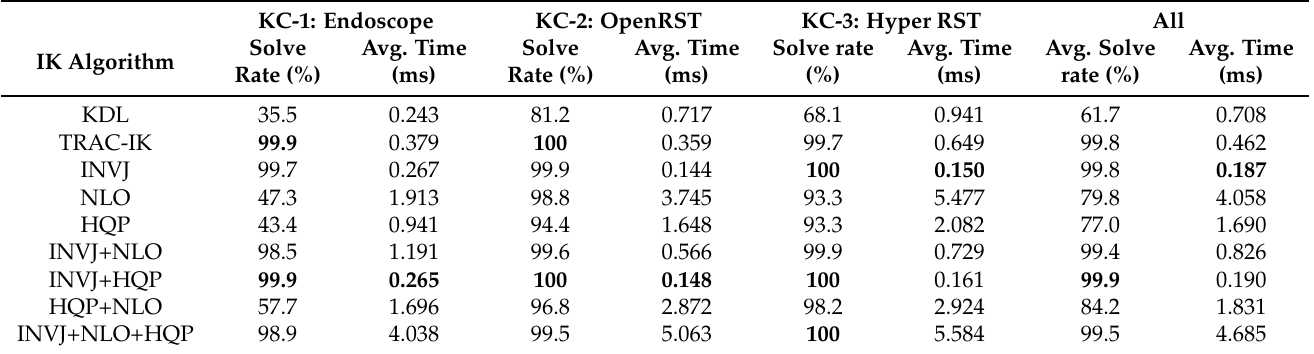
Table 2. A comparison of solve rate and solving time for a total of nine IK solvers: five single-method and four concurrent. The targets are randomly selected from reachable poses. Evaluation is performed for three kinematic chains commonly found in robot-assisted surgical applications: KC-1 (Endoscope Holder), KC-2 (Manipulator + OpenRST), and KC-3 (Manipulator + Hyper-redundant RST). The highest values in each column are highlighted in